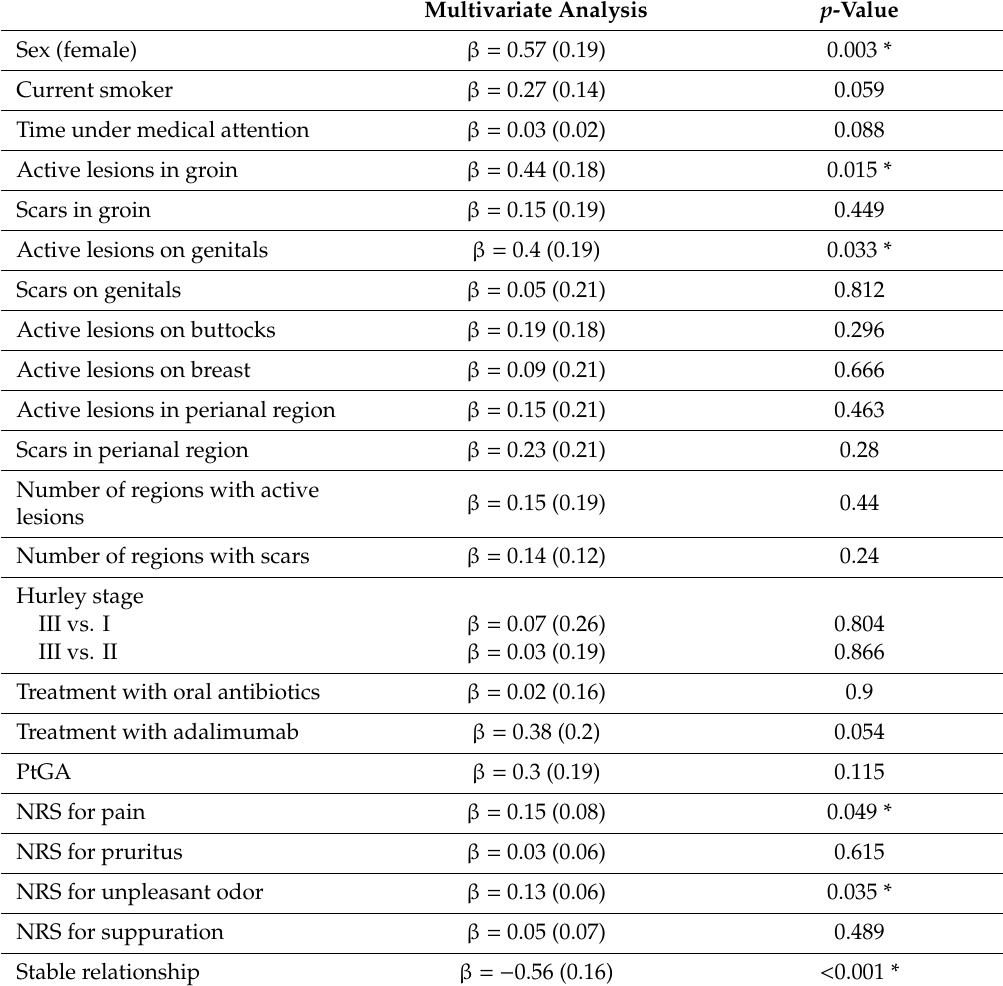
Table 4. Multivariate analysis of factors associated with sexual distress in patients with